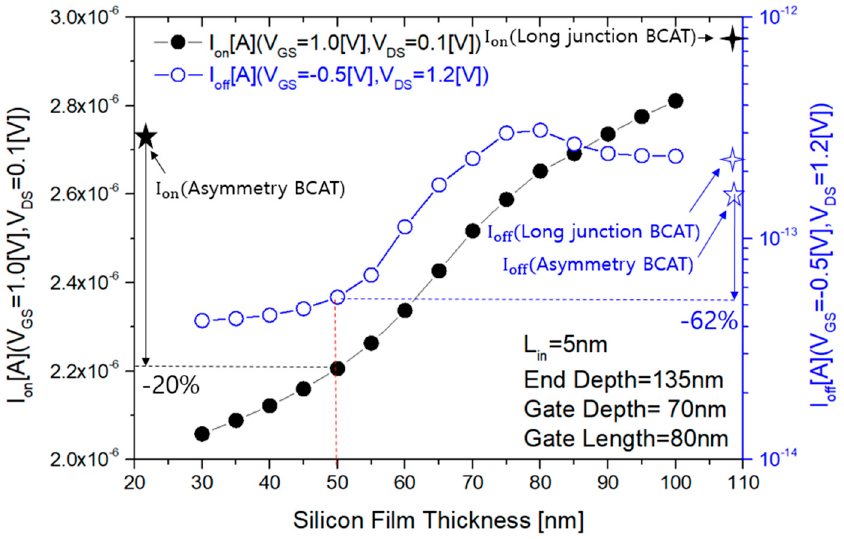
Figure 13. I on and I off change at a gate depth = 70 nm in Pi-BCAT according to the silicon film thickness.